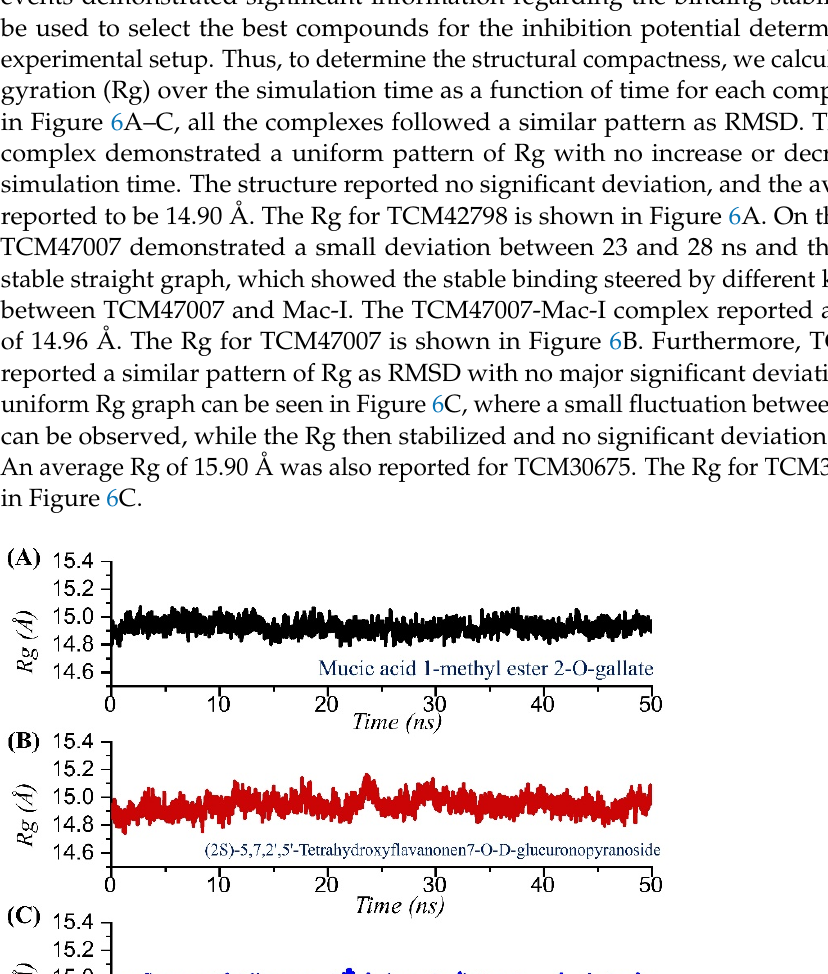
Figure 7. Residual flexibility analysis of the TCM42798, TCM47007, and TCM30675 complexes. 2.6. Hydrogen Bonding Analysis Hydrogen bonds confer strength to the binding of small molecules. The binding of small molecules is steered by hydrogen and many other bonds, which consequently show the inhibitory features. To determine the binding strength, we calculated the total number of hydrogen bonds and the population, and the simulation trajectories were analyzed. In TCM42798 or mucic acid 1-methyl ester 2-O-gallate, the average number of hydrogen bonds was reported to be 82, while in the case of TCM47007 or (2S)-5,7,2’,5’-Tetrahy- droxyflavanone 7-O--D-glucuronopyranoside, the average number of hydrogen bonds